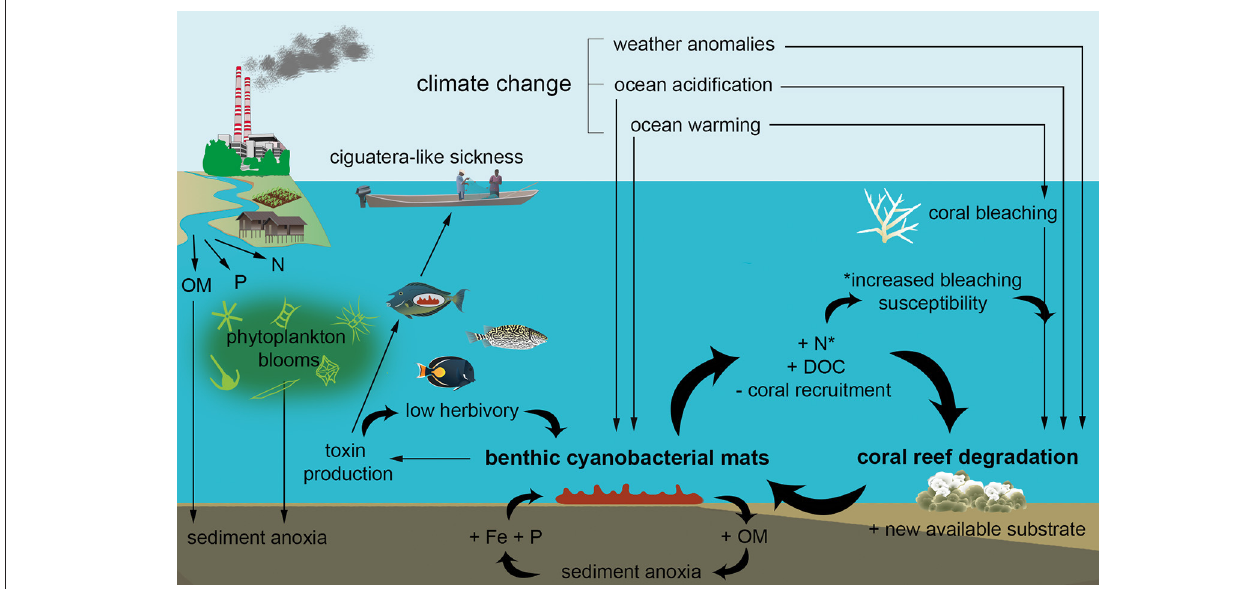
FIGURE 4 | Schematic diagram showing the putative local and global drivers of benthic cyanobacterial mat growth on coral reefs, as well as the associated ecological consequences. Direct positive feedbacks that reinforce reef degradation and benthic mat growth are represented by thick curved arrows. Reef degradation will in turn drive coastal communities increasingly toward land-use changes such as agricultural development, further facilitating nutrient release and reinforcing the cycle. Abbreviations within the figure: N, nitrogen; DOC, dissolved organic carbon; Fe, iron; OM, organic matter; P,